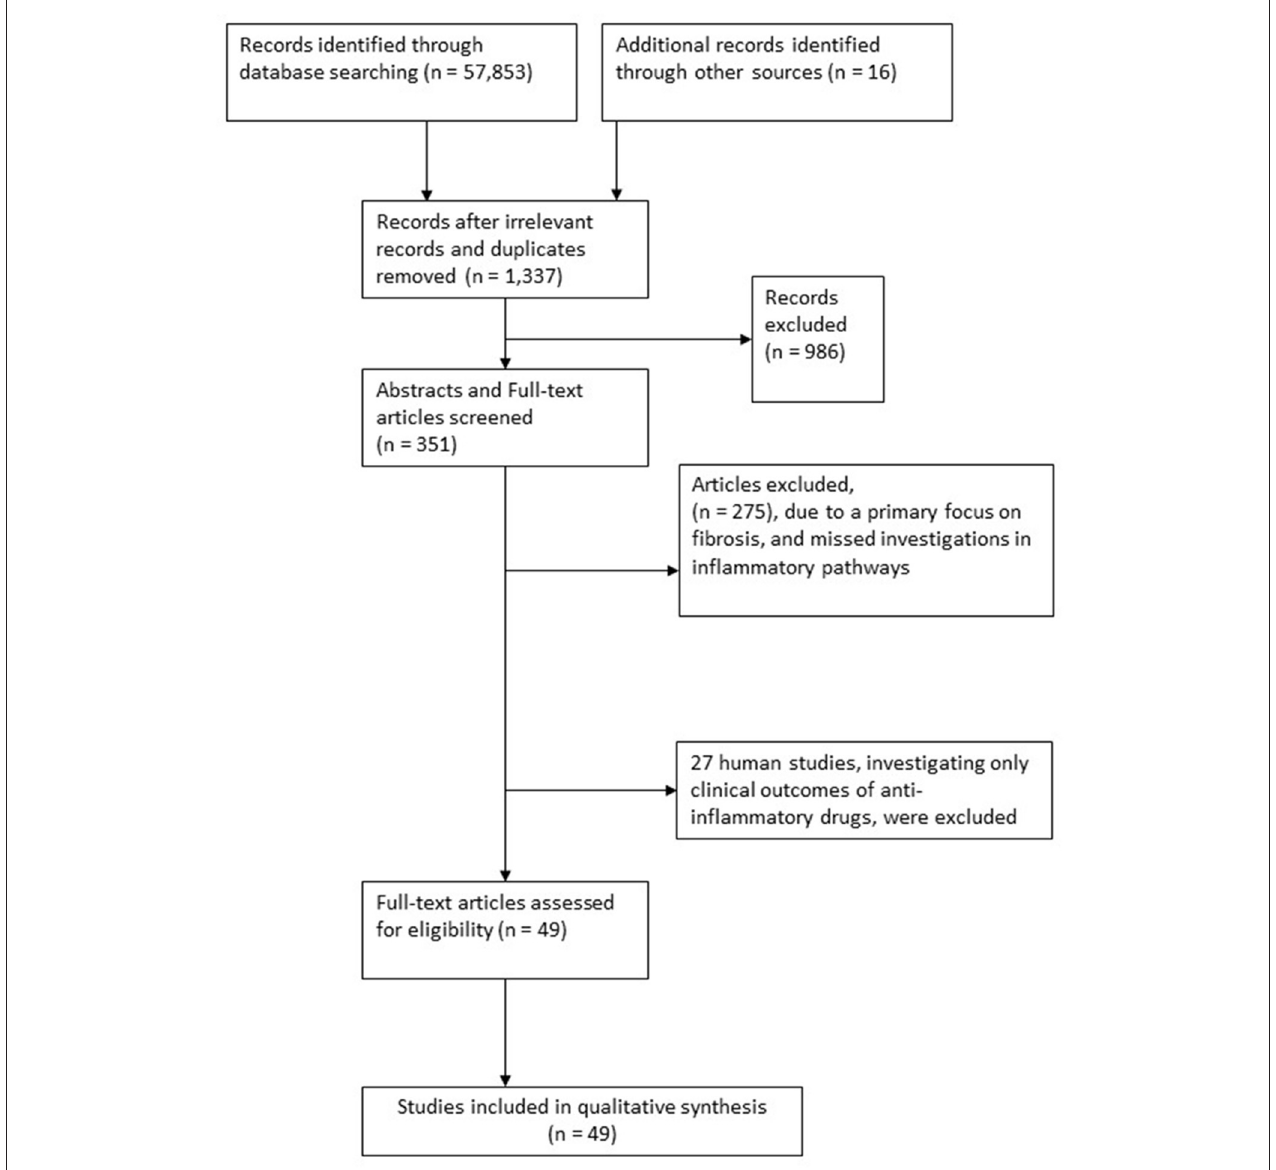
FIGURE 1 | Trial flow